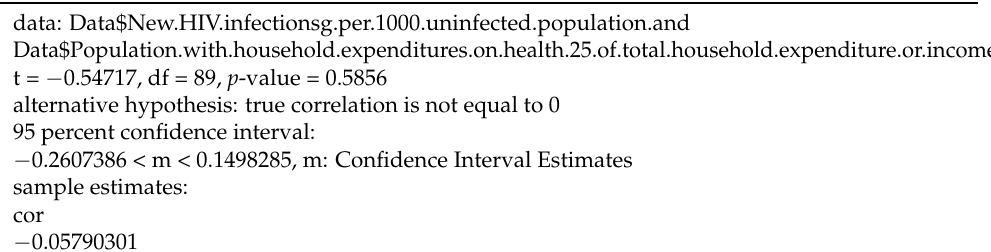
Table 10. STDs (HIV infection) infection rate according to medical expenses (more than 25% of household